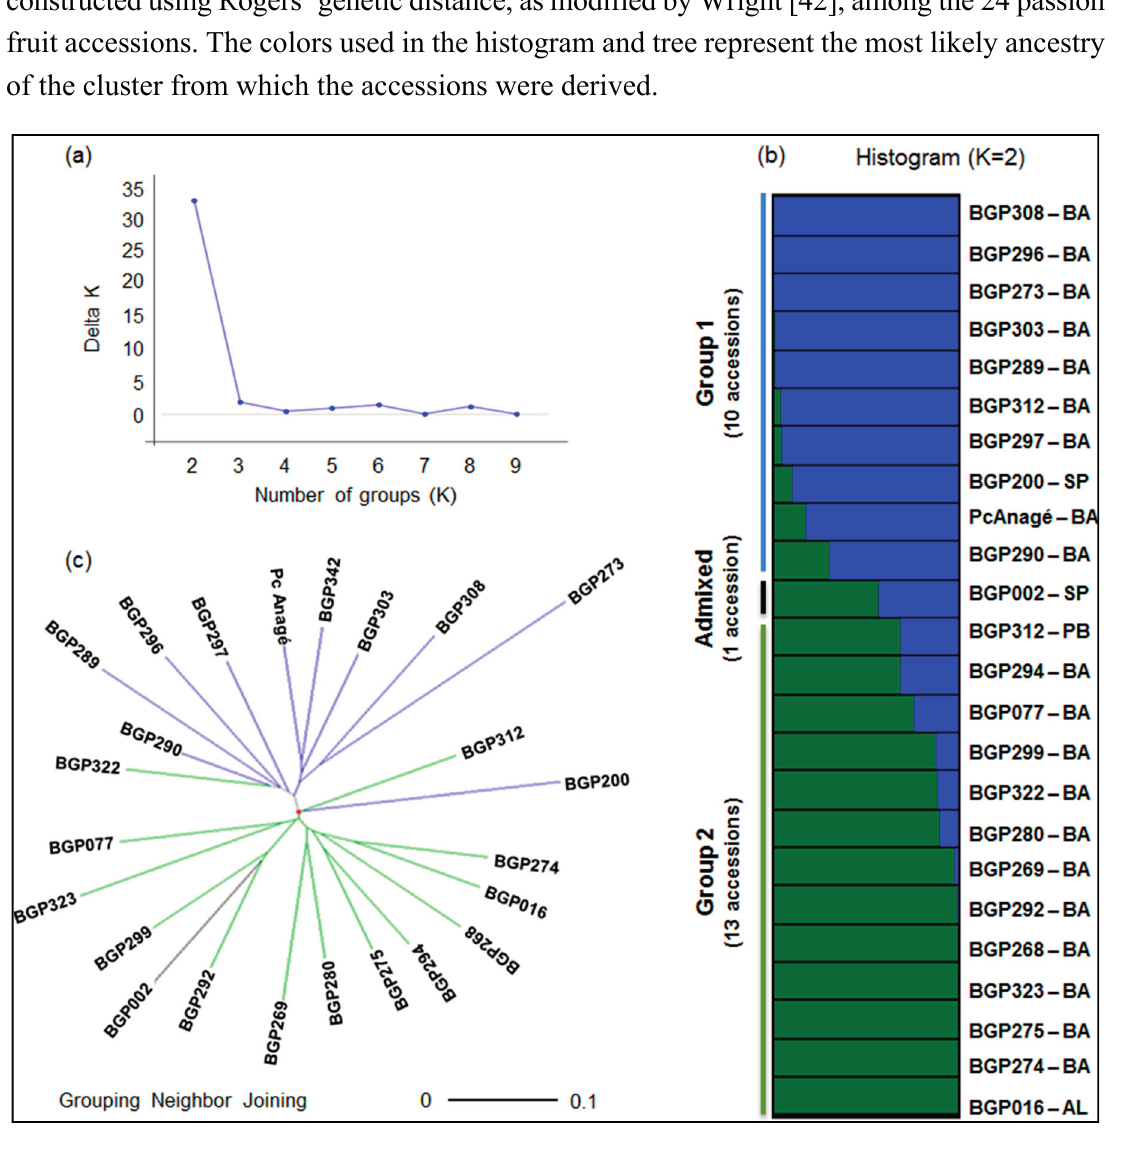
Figure 2. Intraspecific genetic structure of P. cincinnata . Clusters were inferred based